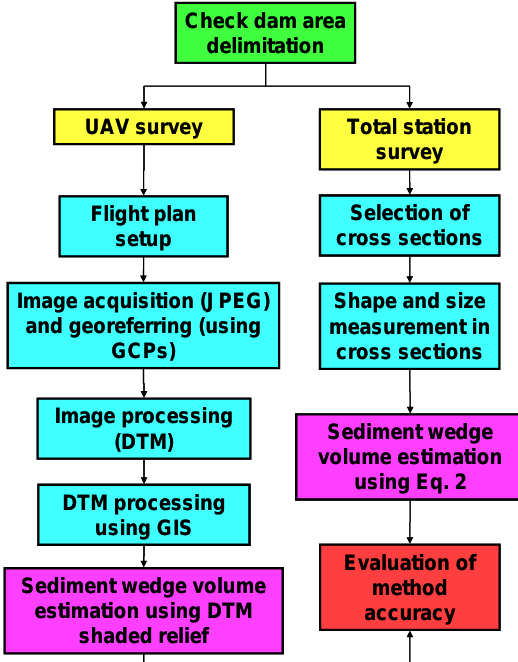
Figure 2. Workflow of the process for calculating sediment wedge behind check dams using aerophogrammetric (by UAV) and topographic (by total station) methods.